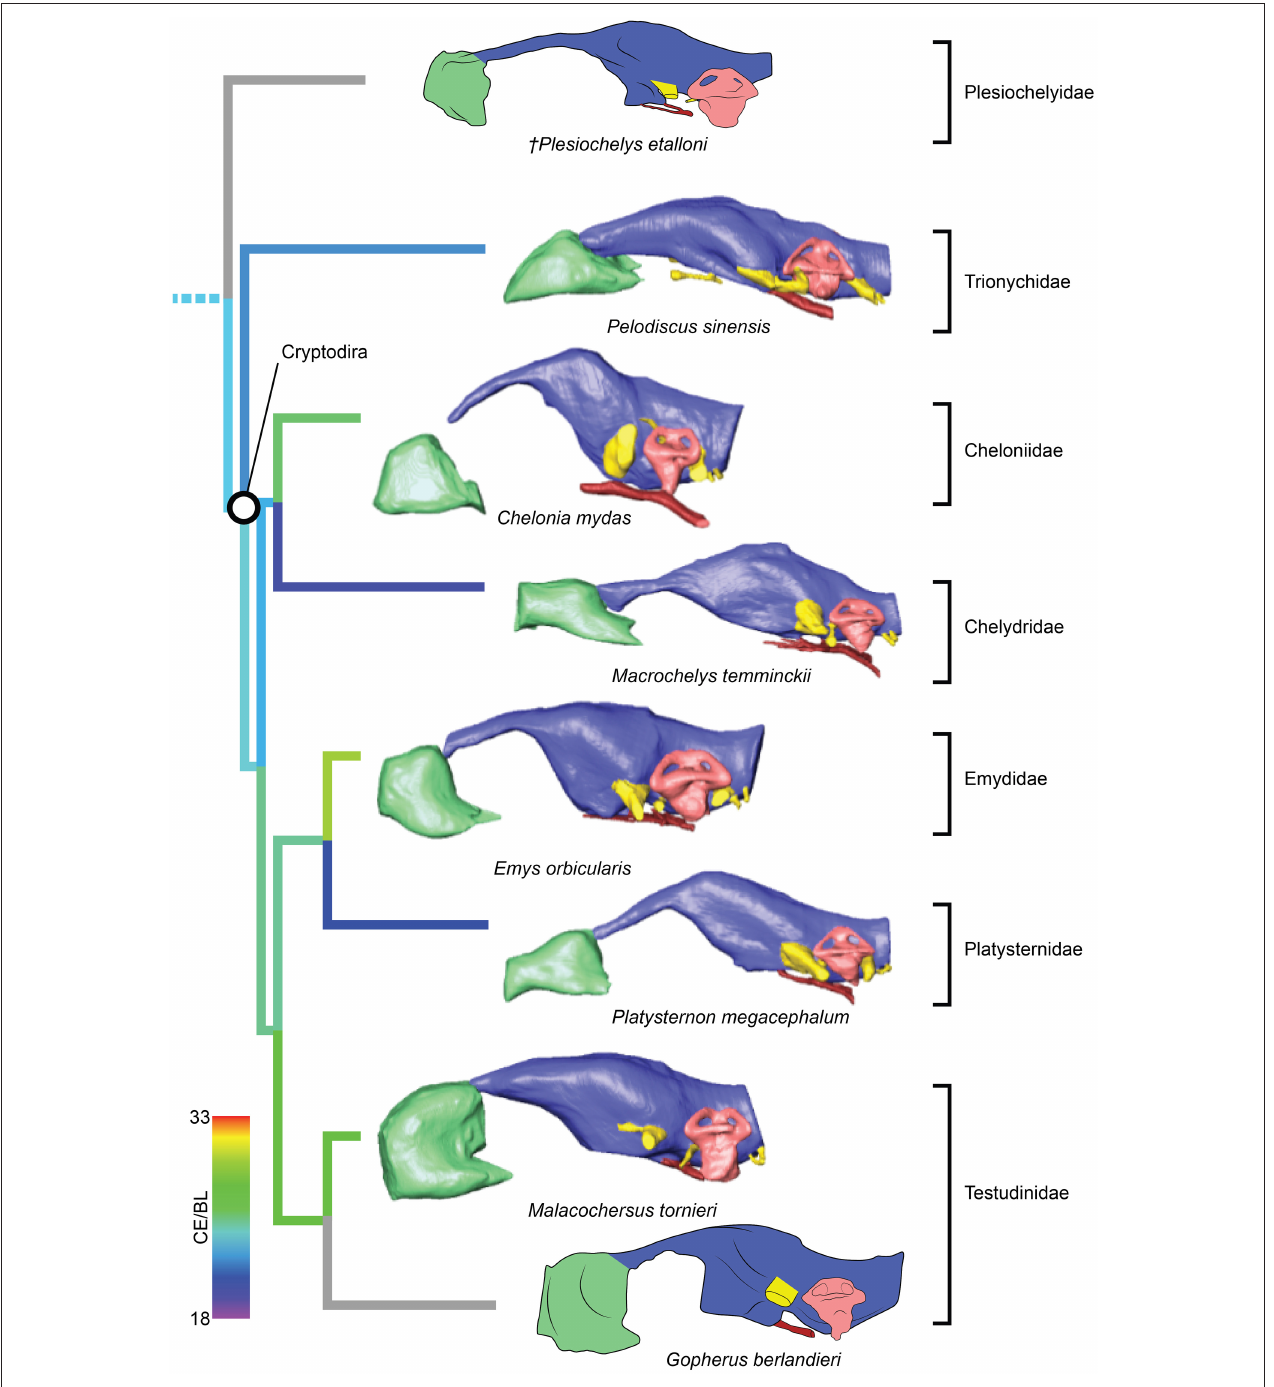
FIGURE 3 | Comparative endocranial anatomy of different pan-cryptodiran taxa. Original reconstructions and redrawn endocasts ( Plesiochelys etalloni from Carabajal et al., 2013; Gopherus berlandieri from Paulina-Carabajal et al., 2017) in left lateral view. Topology based on Joyce et al. (2016) and Guillon et al. (2012). Heat mapping on branches based on the ratio (CE/BL) between cubic root of endocast volume and basicranial length ( Table 1 ).